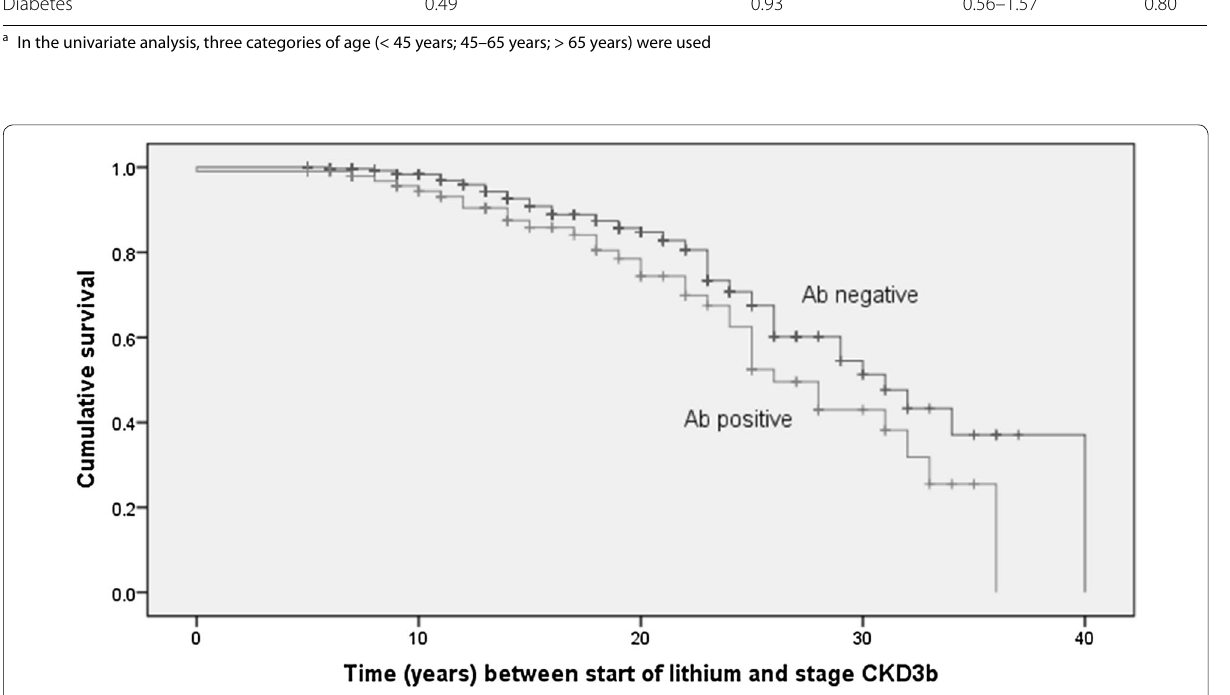
Fig. 1 Kaplan–Meier curve showing the time taken between start of lithium treatment and the decline to stage